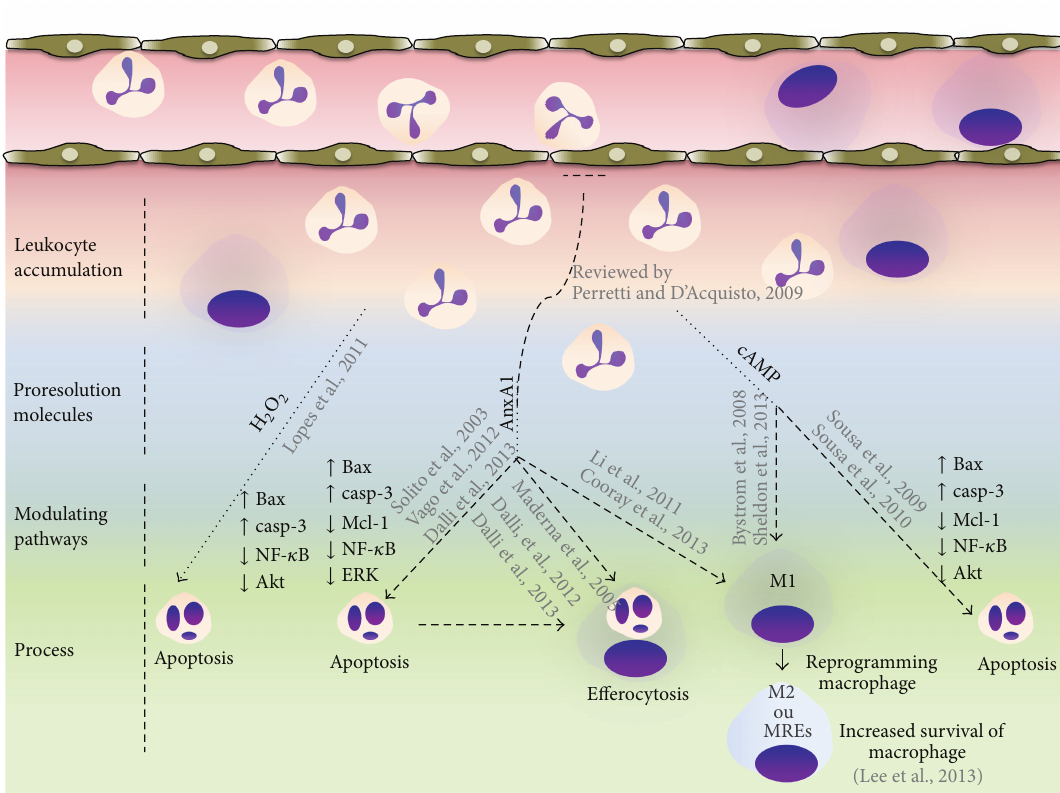
Figure 1: Targets to promote granulocyte apoptosis and inflammation resolution. During early phase of inflammation production of proinflammatory mediators and activation of signal survival pathways (PI3K/Akt, NF- 𝜅 B, MAPKs, and CDKs) promotes leukocyte accumulation and survival in the inflammatory site. While inflammatory response evolves, local activation/release of proresolution mediators occurs and pathways (H 2 O 2 , AnxA1, and cAMP) that control further granulocyte ingress and turn on a resolution program. These resolution molecules, in addition to proresolving lipid mediators which are not highlighted in this cartoon, downregulate survival pathways and activate an apoptosis-associated program in granulocytes. Resolution molecules are also able to promote efferocytosis and coordinate reprogramming of macrophages. These events will reestablish tissue